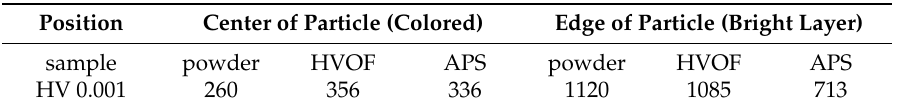
Table 4. Nanoindentation hardness of the different phase areas of the AISI 316L powder, the HVOF coating, and the APS coating using the gas nitrocarburized